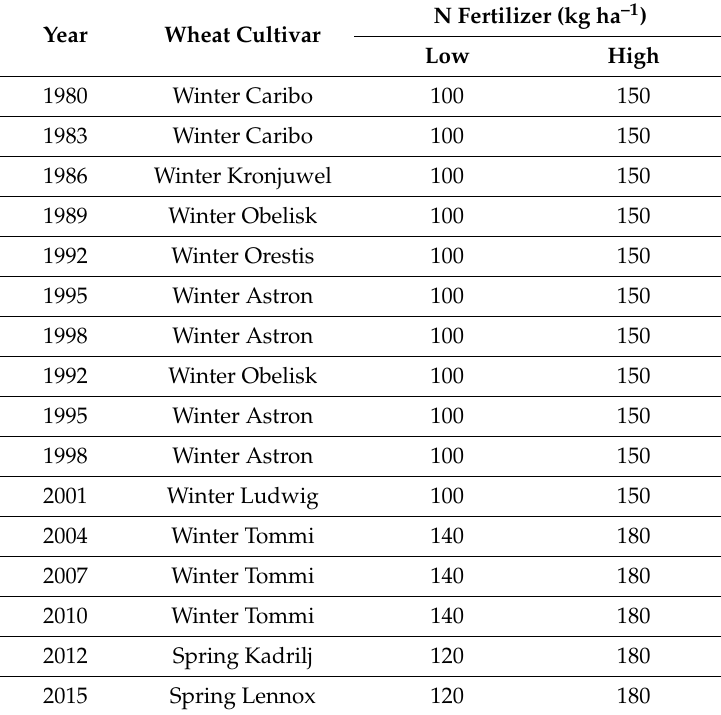
Table 3. Wheat cultivars and the amounts of nitrogen fertilizer.